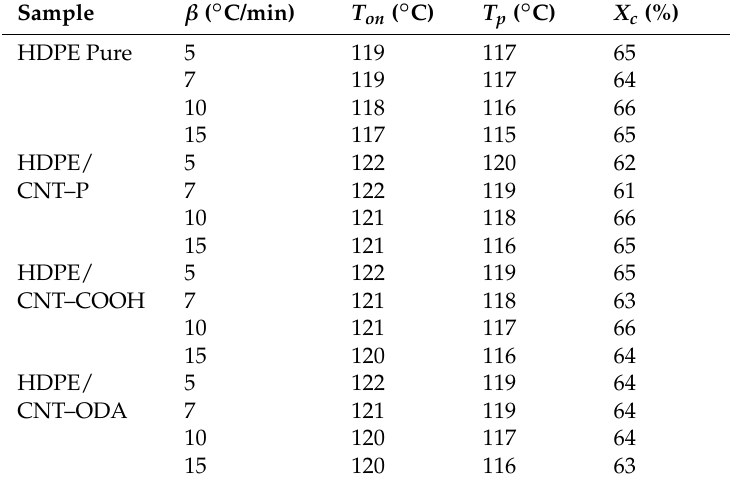
Table 2. Summarized DSC results at various cooling rates (5, 7, 10, and 15 ◦ C/min) for pure HDPE and HDPE/CNT